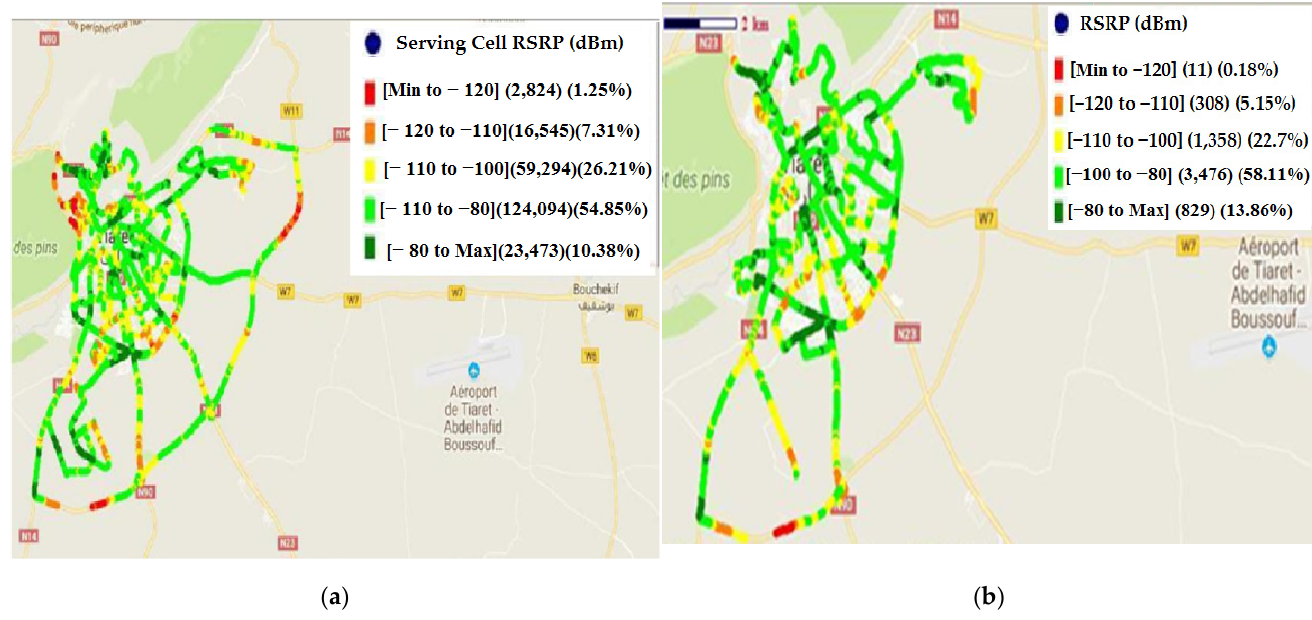
Figure 7. RSRP distribution: ( a ) before treatment; ( b ) after treatment.